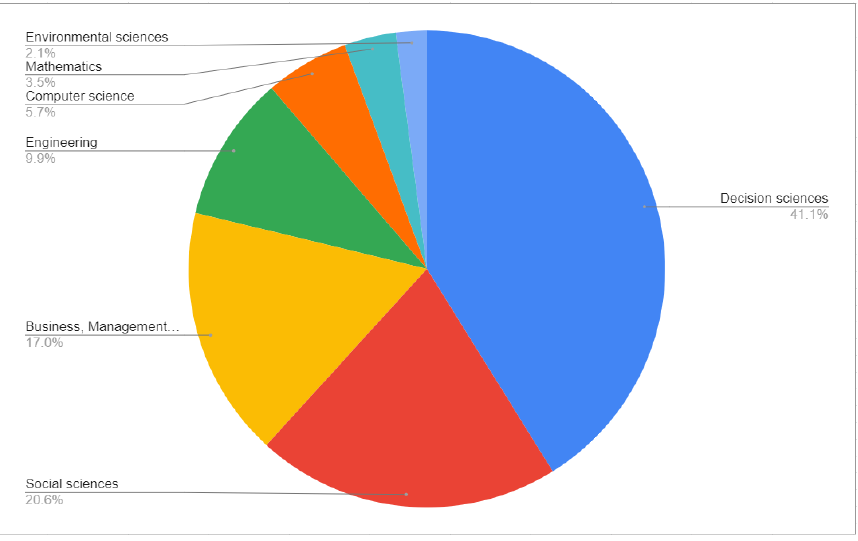
Figure 3. Distribution of documents by subject